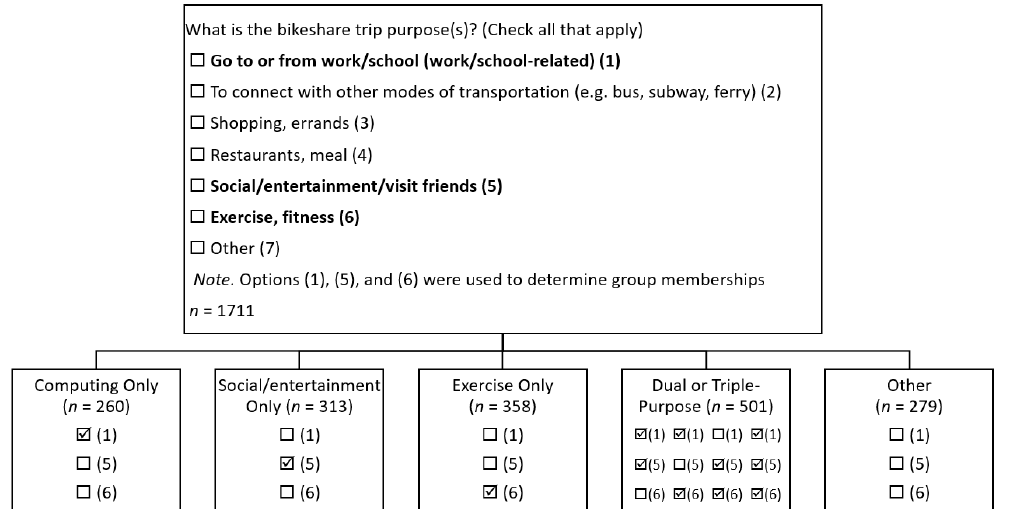
Figure 1. The method for grouping participants of five bike share trip purposes; Bold options were used to divide participants into five groups.